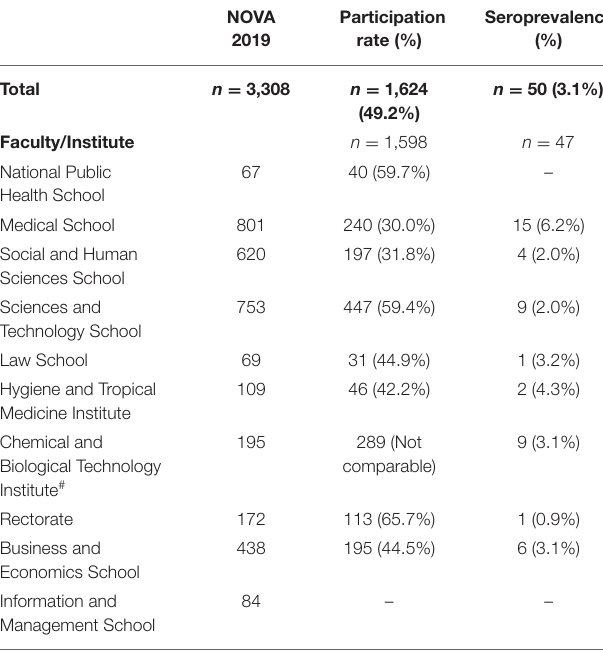
TABLE 3 | Seroprevalence University sample distribution by organic